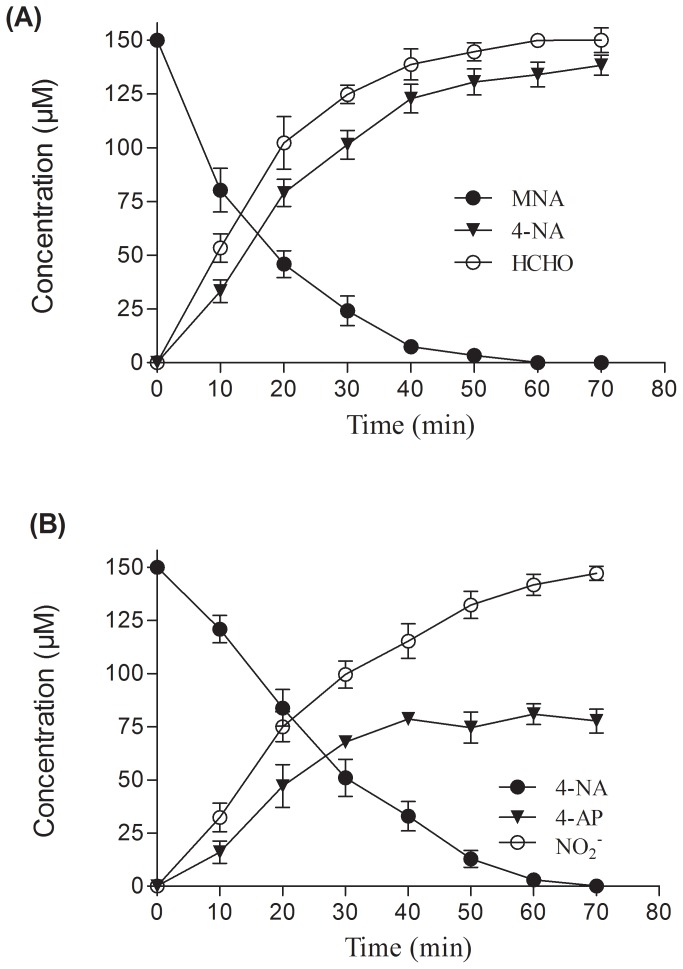
Stoichiometric N-demethylation of MNA and monooxygenation of 4-NA by cell-free lysates prepared from MNA grown cells of strain FK357.(A) N-demethylation of MNA to 4-NA along with concomitant production of HCHO. (•), MNA; (▾), 4-NA; (○), HCHO. (B) Monooxygenation of 4-NA to 4-AP with stoichiometric release of NO2
−. (•), 4-NA; (▾), 4-AP; (○), NO2
−. Values are presented as arithmetic mean of data obtained from experiments carried out in triplicate; error bars represent standard deviation.